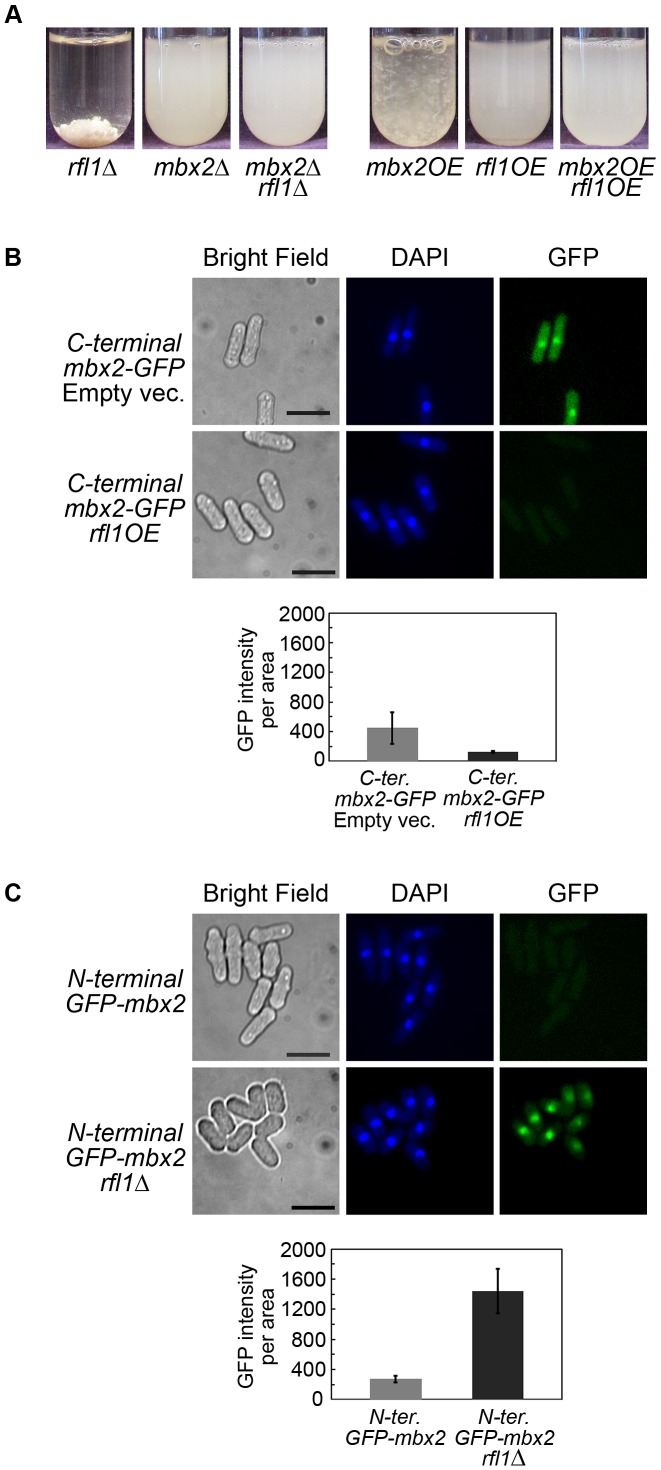
Rfl1 represses mbx2+ expression.(A) Genetic interactions between mbx2+ and rfl1+. The flocculation phenotype of the rfl1Δ mutant is abolished by deletion of mbx2+ (left panel). In addition, the flocculation caused by overexpression of mbx2+ is abolished by rfl1+ overexpression (right panel). The deletion and overexpression strains were cultured in YES and EMM minus thiamine media, respectively, for 24 hours at 30°C. (B) The expression of C-terminal GFP-tagged mbx2+ under native control is reduced by ectopic expression of rfl1+. The C-terminal GFP-tagged mbx2+ strain is a hypermorphic allele that exhibits constitutive flocculation and nuclear Mbx2-GFP expression. The C-terminal GFP-tagged mbx2+ strain containing nmt1-driven rfl1+ or empty vector was inoculated at approximately 104 cells/ml in EMM minus thiamine medium and cultured for 20–30 hours at 30°C until late log phase. The strain containing the empty vector was deflocculated in 2% galactose prior to fluorescence microscopy. This procedure was not required for the rfl1OE strain because it was no longer flocculent. (C) Deletion of rfl1+ results in the expression of native-controlled N-terminal GFP-tagged mbx2+. The N-terminal GFP-tagged mbx2+ strain in a wild type and rfl1Δ background were cultured to mid-log phase in YES medium. The bar graph compares the mean and standard deviation of overall cellular Mbx2-GFP (B) and GFP-Mbx2 (C) signals between the experimental and control strains with significant difference of p<0.001 (Welch's two tailed t-test; n = 50, df = 50 for each experiment). Cells were stained with DAPI to visualize nuclei. Scale bar, 10 µm.